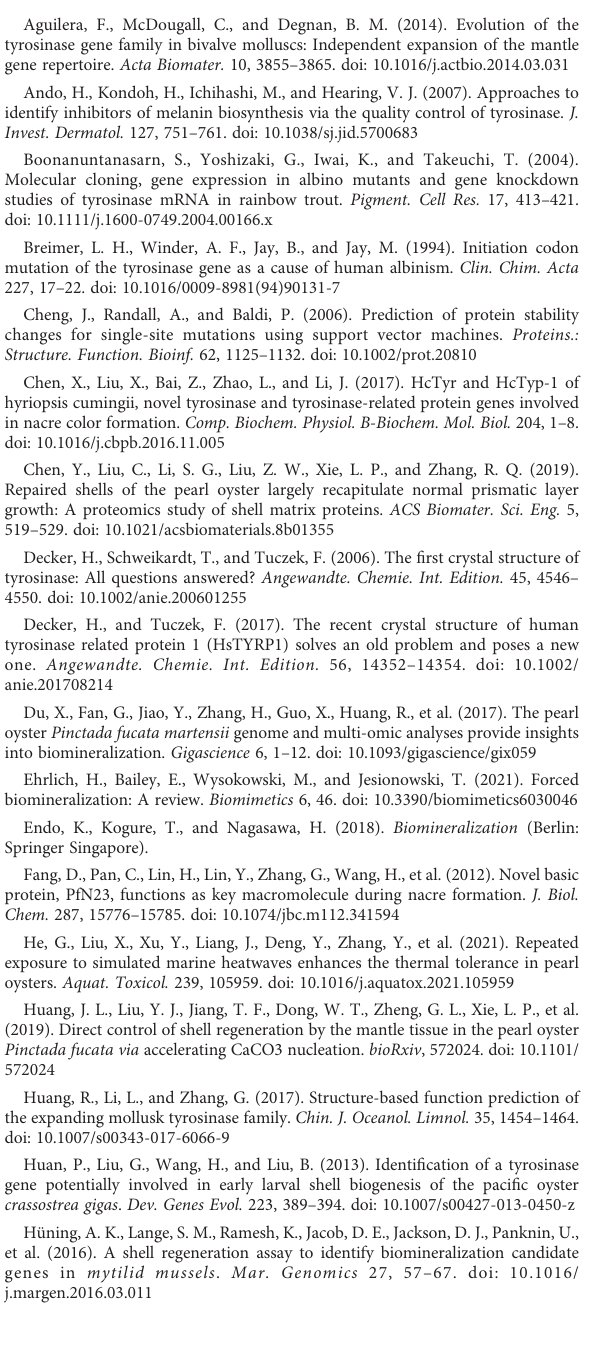
SUPPLEMENTARY FIGURE 1 Sequencesofthe6clonedtyrosinase.Thenucleotidewithaframerepresents the start and stop codons. Single underlined amino acid sequences are the signal peptide or transmembrane region. Double underlined amino acid sequences are the region of tyrosinase domain. Amino acids marked with graybackgroundareCuAregions.Aminoacidsmarkedwithgraybackground and in italics are CuB regions.